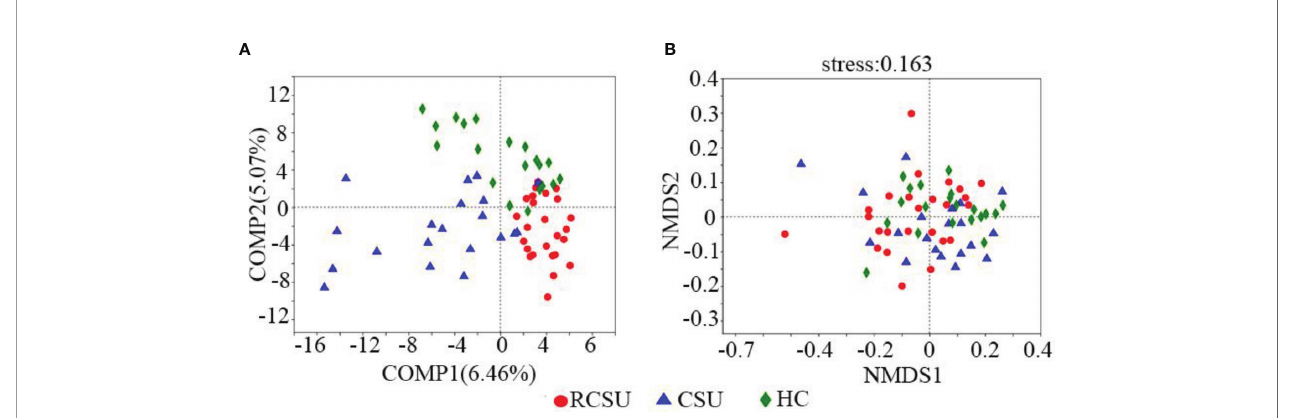
FIGURE 2 | b Diversity analysis of gut microbial structure. (A) Comparison of distance rank on OTU level among three groups was shown by partial least squares- discriminant analysis (PLS-DA). (B) Similarities in the microbial composition on OTU level among three groups were presented by non-metric multidimensional scaling (NMDS). R, RCSU; N, CSU; C, HC.